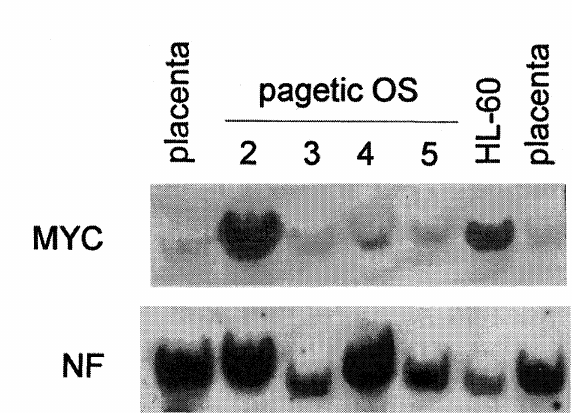
Fig. 1. MYC gene amplification analysis by Southern blotting.